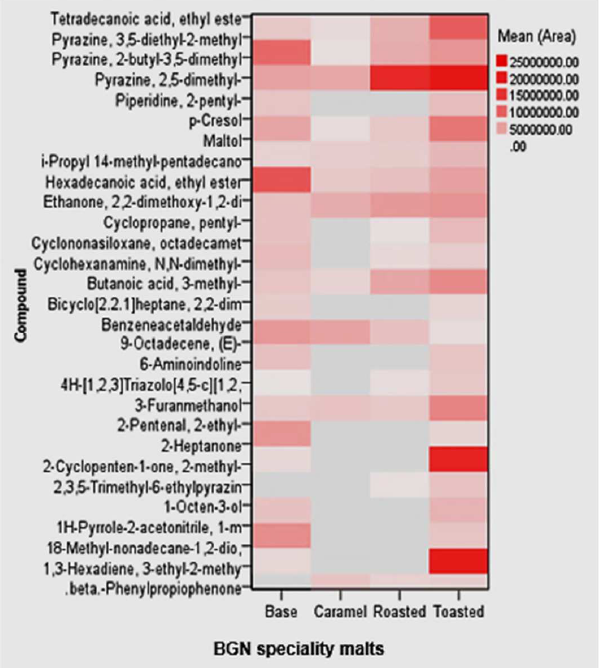
Figure 8. Heat plots of the volatile metabolites of Bambara groundnut speciality malts.